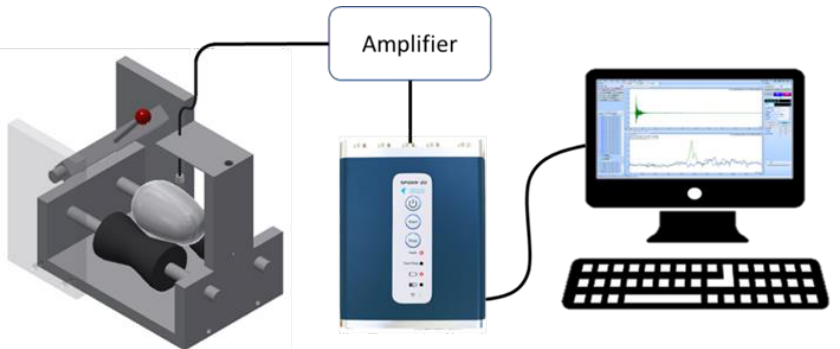
Figure 1. Schematic of measurement setup.